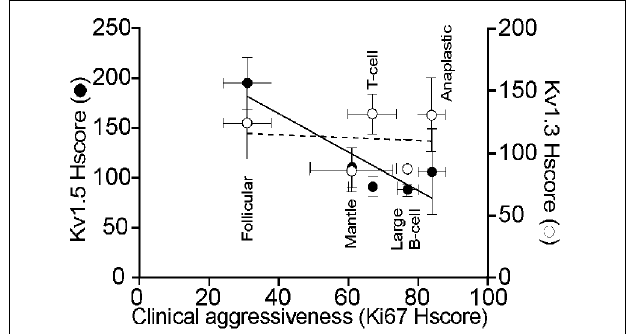
( • ) Kv1.5 Hscore. Results are mean ± SEM of Kv1.3 and Kv1.5 Hscore plotted against Ki67 Hscore as a marker of the clinical aggressiveness of